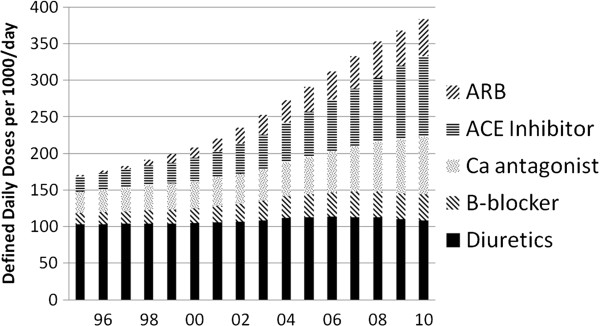
National consumption of the commonest antihypertensive agents 1995–2010.